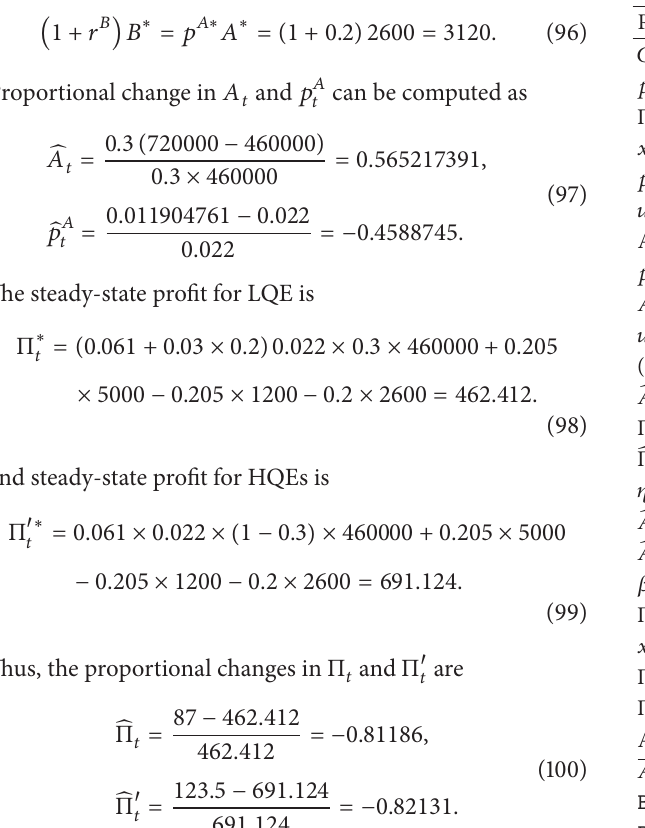
Table 3: Computed asset securitization